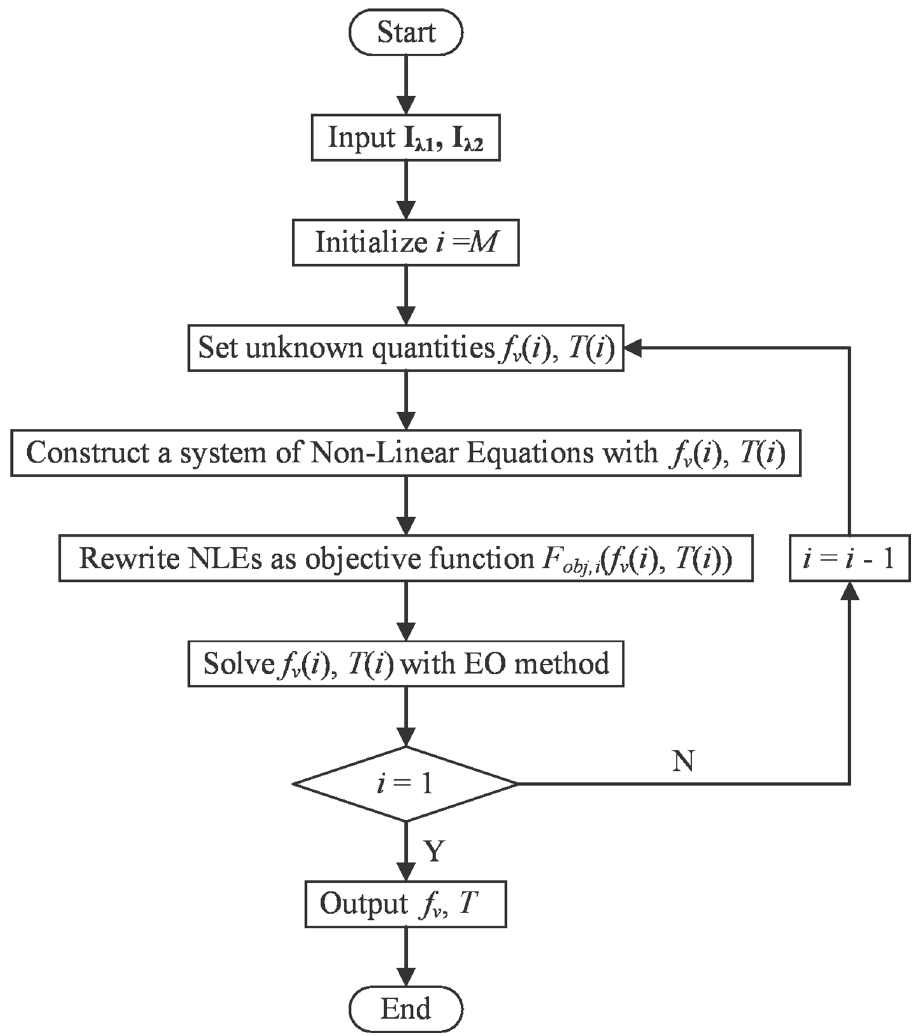
Figure 3. A brief flowchart to solve the inverse radiative transfer problem based on optimization